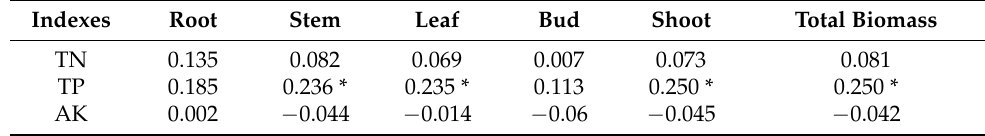
Table 3. The correlation coefficients between TN, TP, and AK in the rhizosphere and plant bio- mass.